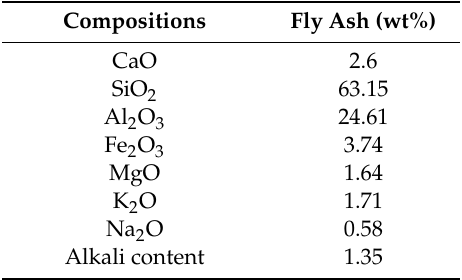
Table 3. Physical properties of the glass fiber.